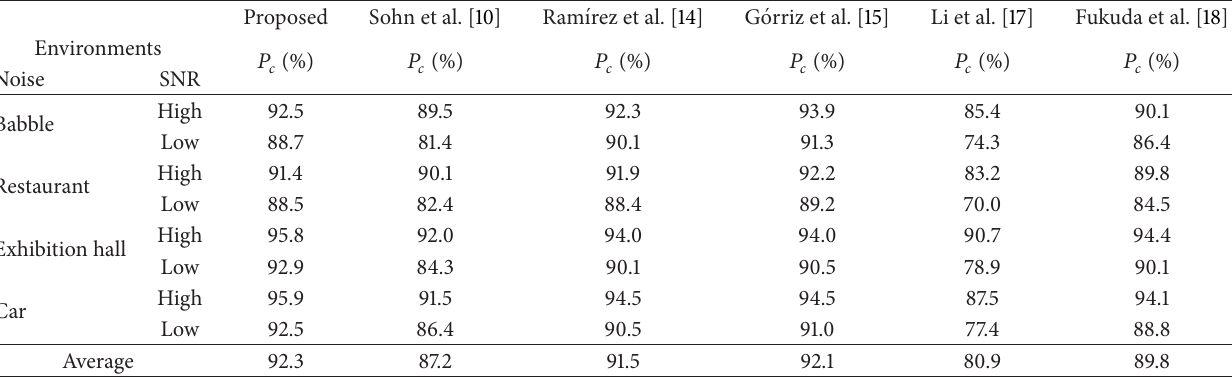
Table 1: Comparison of the proposed algorithm to conventional algorithm in the utterance based speech segment detection test for various noise environments.